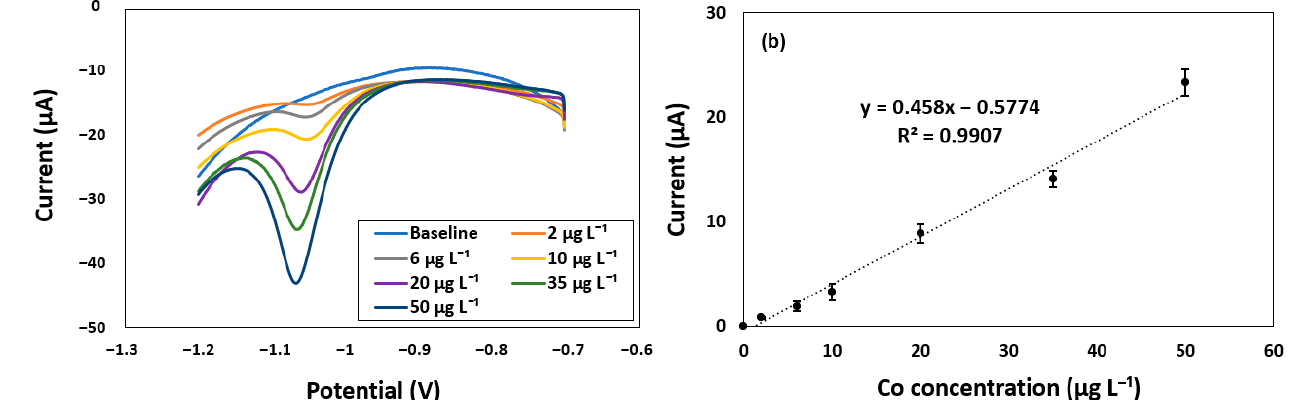
Figure 8. Characterization and evaluation of the Bi ‐ chitosan sensor for Co(II) detection in real natu ‐ ral water samples. ( a ) SWAdCSV with various Co(II) concentrations (2–50 μ g L − 1 ) and ( b ) a corre ‐ sponding calibration curve. Deposition time is 120 s with a deposition potential of − 0.7 V, frequency of 60 Hz, amplitude of 50 mV, and DMG concentration of 0.2 mM.